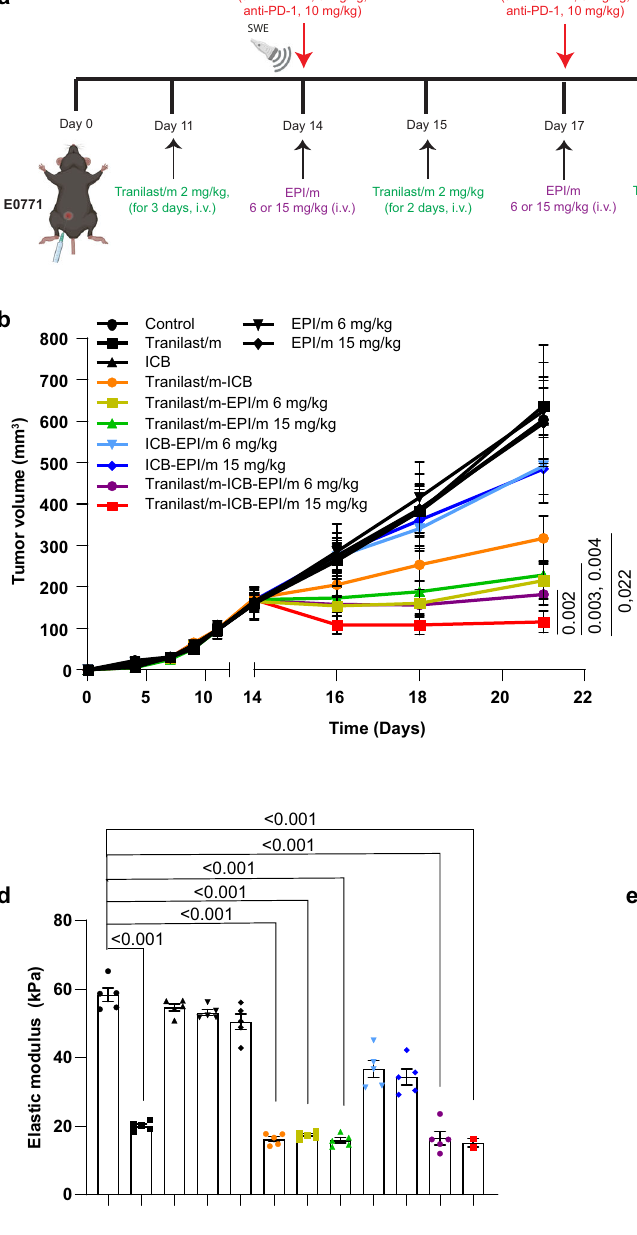
presented as mean ± SE. For ( b – d ), statistical analyses were performed by com- paring means between two independent groups using the unpaired parametric Welch t test. e Relative change in primary tumor volume at the end of the experi- mentcompared totumorvolumepriortoinitiationof thetreatmentsas afunction oftheelasticmodulusbeforetreatmentinitiation( R 2 =0.77,quanti fi ableanalysisof how well the line of best fi t, fi ts the data). ( a ) was created with